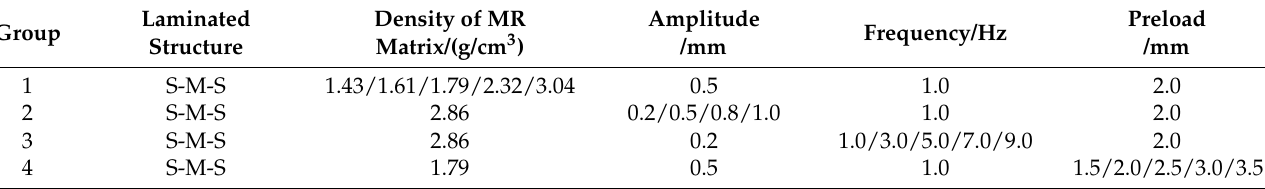
Table 6. Single-factor control test